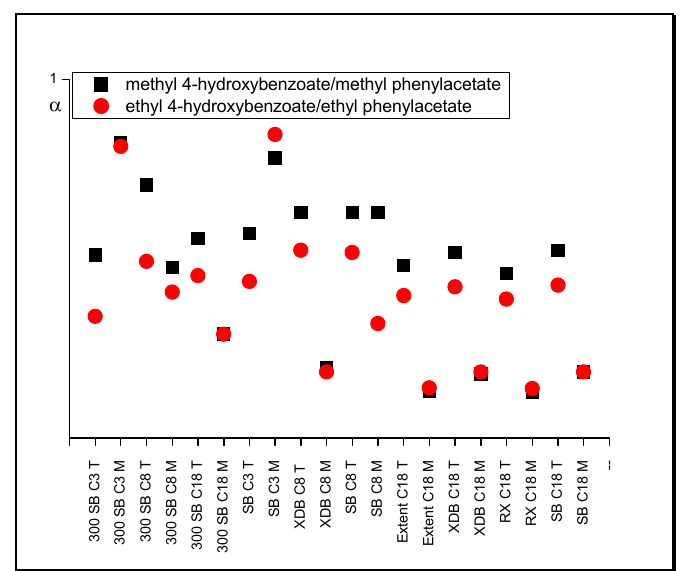
Figure 6. Separation factor, α , values of esters in systems with different nonpolar stationary phases and methanol (M) in water and tetrahydrofuran (T) in water (modifier concentrations as in Table 1).